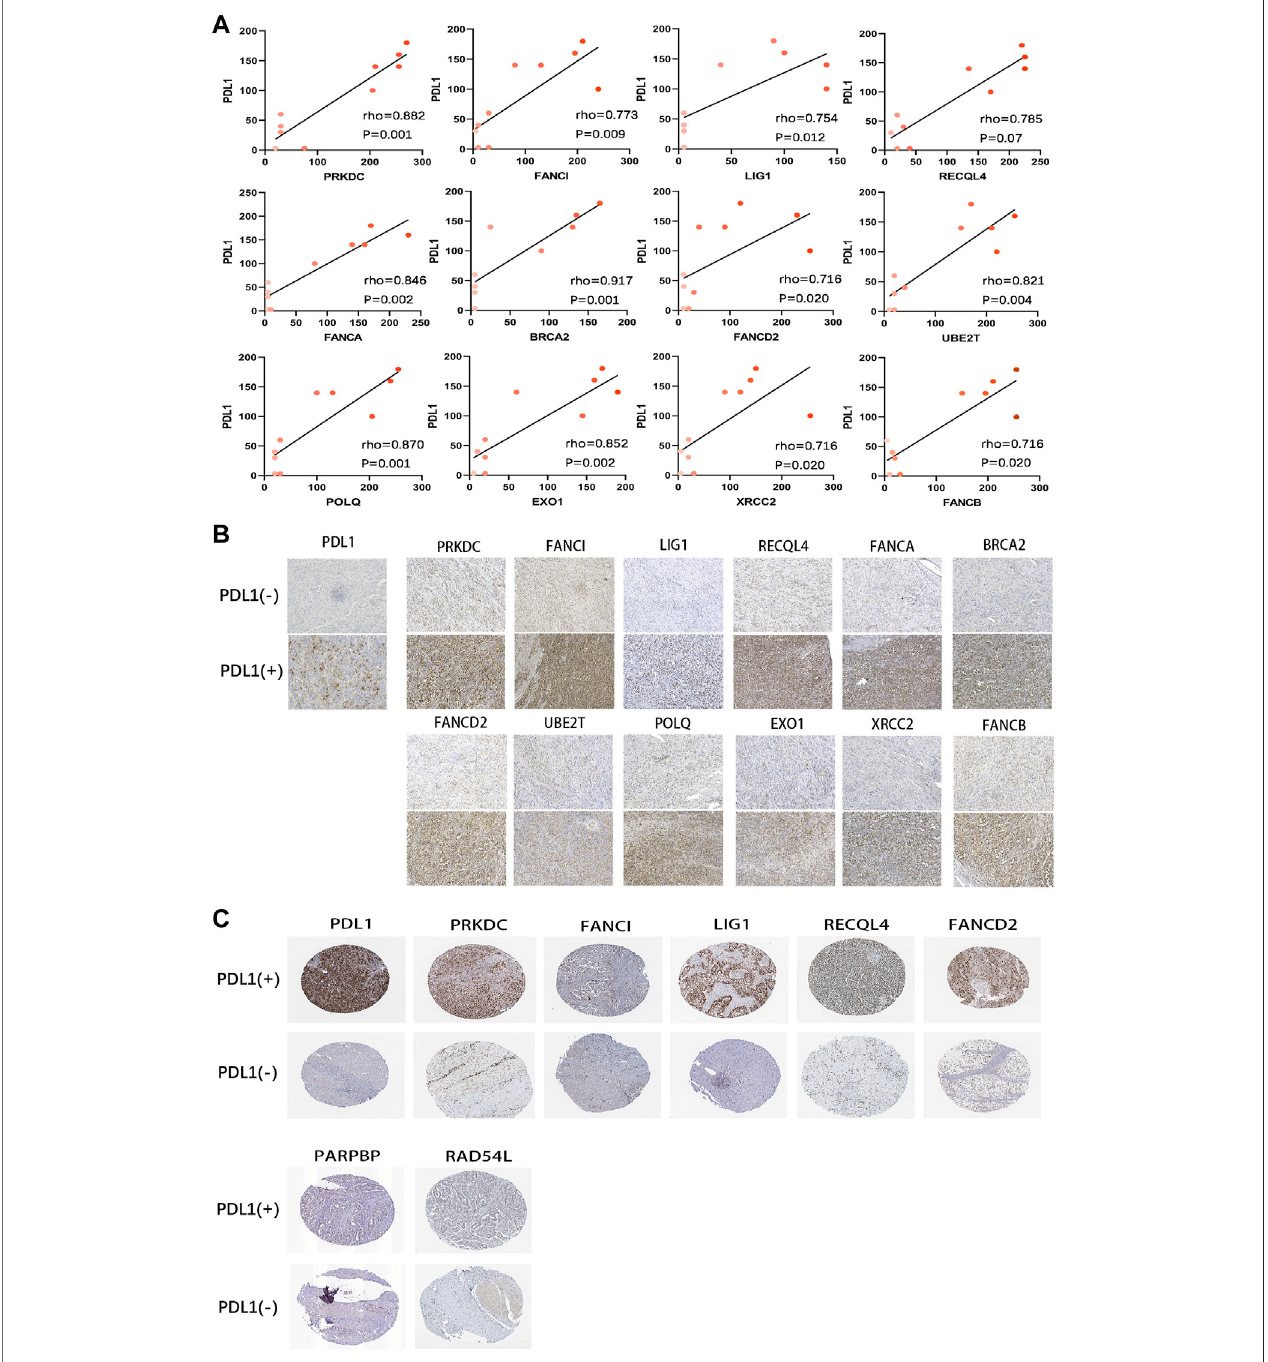
FIGURE10| CorrelationofproteinexpressionbetweenPD-L1andDRGS. (A) TheSpearman ’ scorrelationwasperformedtoanalyzetherelationshipbetweenPD- L1andDRGSinIHCgastriccancersamples( n =10).ThecolordepthofthepointsrepresentstheIHCscoreofDRGS; (B) Proteinexpression(IHC)ofDRGSinPD-L1( − ) patients and PD-L1 (+) patients; (C) Data from the HPA database.